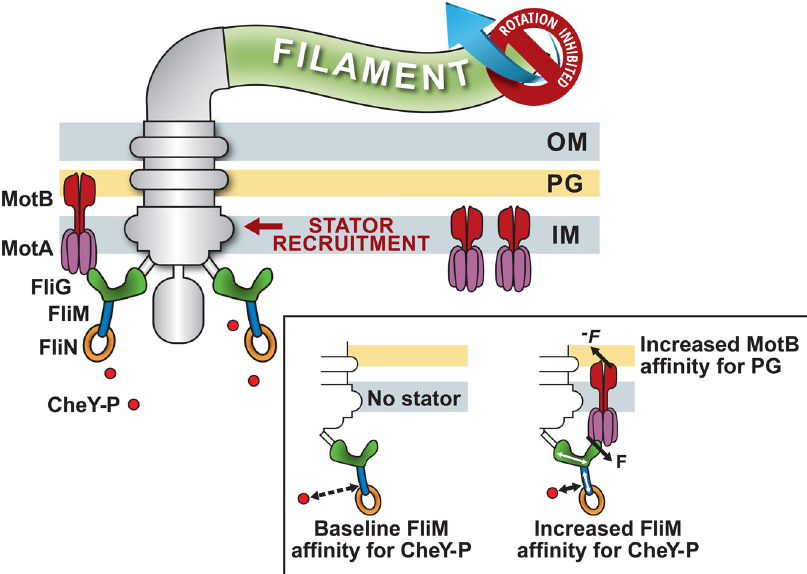
Fig. 3 Model for mechanosensitive control in the fl agellar motor. Independent stator units (MotA purple, MotB maroon units) deliver torque by interacting with the C-terminal domain of FliG (green) to rotate the transmembrane fl agellar motor. The conformational state of the FliG ring determines the direction of rotation. The default conformation is CCW; binding of CheY-P to the FliM (blue) and FliN (orange) complexes increases the probability that the FliG ring will adopt a CW conformation. An increase in the viscous resistance to the rotation of the extracellular fl agellar fi lament causes the transmembrane fl agellar motor to recruit additional stator units. Inset: Left : In the absence of stator units, the af fi nity CheY-P binding is at a baseline level. Right : Increased mechanical force ( F ) on the FliG C domain due to the mechanosensitive recruitment of a stator unit induces conformational shifts (white arrows) in FliM/FliN, increasing their af fi nity for CheY-P. According to our model, the equal and opposite force ( − F ) strengthens the association of the peptidoglycan-binding domain of MotB with the cell wall, increasing the dwell time of the stator unit at the motor 8 . The torque-mediated increase in CheY- P af fi nity compensates for the increased resistance to changes in the conformation of the FliG ring, thereby maintaining a constant motor sensitivity (basal CW bias ).